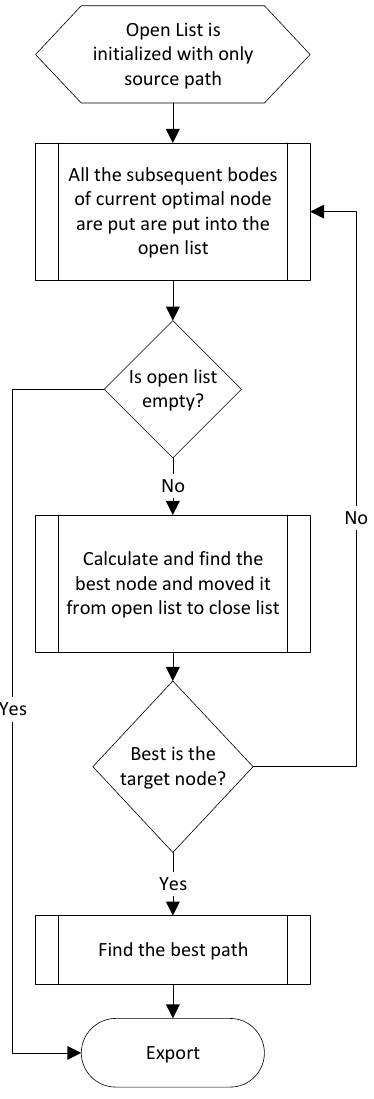
Figure 1. Flowchart of the improved Dijkstra algorithm used in path